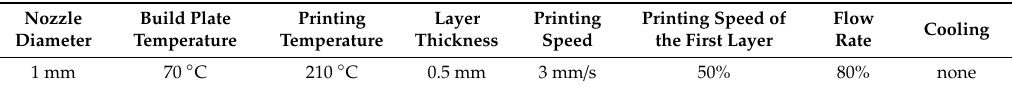
Table 2. Established printing parameters.